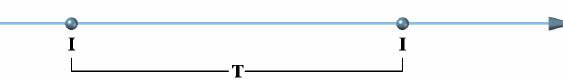
Figure 4: The two time elements and their notations.